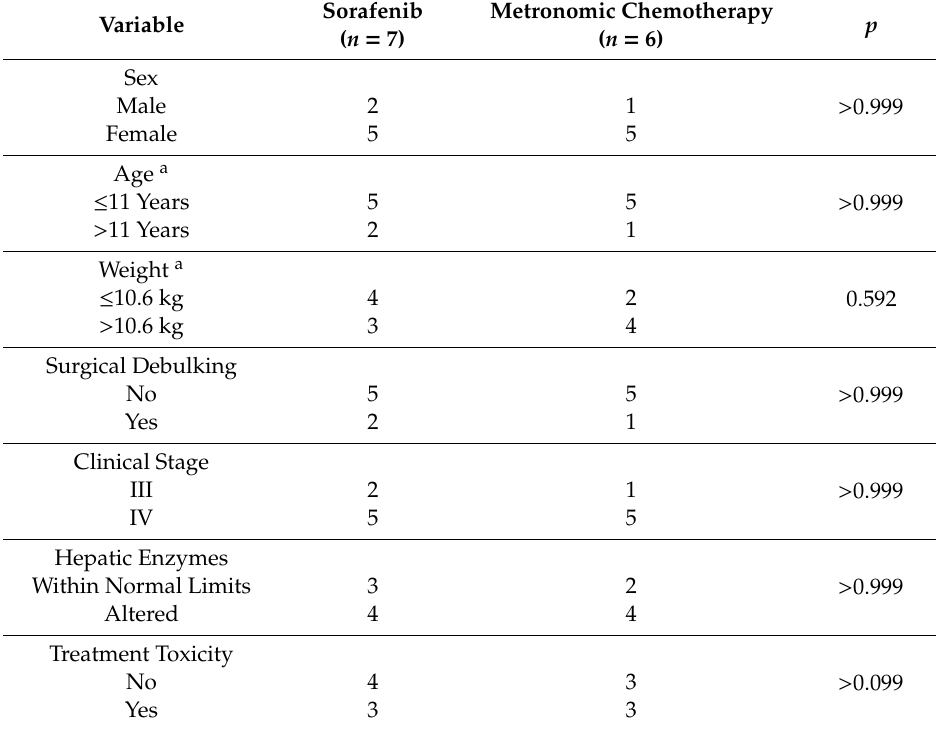
Table 2. Demographic information and distributions of variables potentially associated with prognosis of 13 dogs with hepatocellular carcinoma treated with sorafenib or metronomic